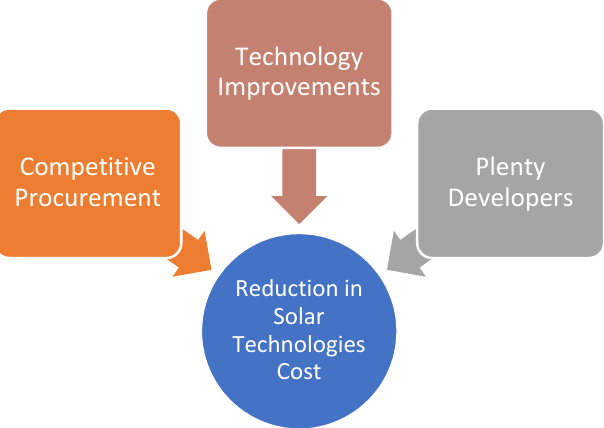
Figure 1. Summary of drivers of the reduction in solar technology costs.